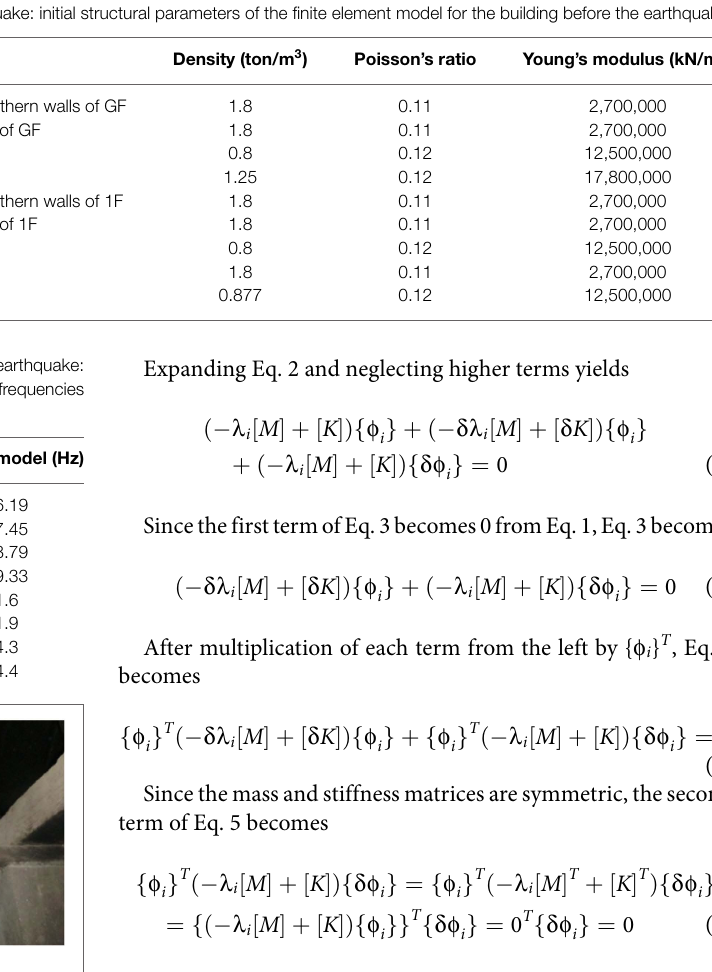
FIGURE 8 | Possible reason of overestimate of stiffness parameters. (A) Soil filled inside the brick wall. (B) Deterioration of timbers and imperfect